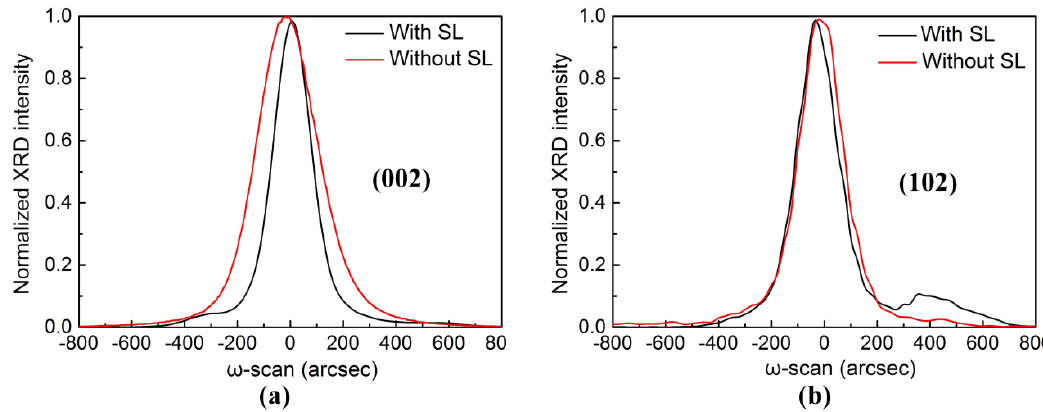
Figure 5. ( a ) Symmetric (002) and ( b ) asymmetric (102) XRD ω -scan rocking curves of green LEDs without and with an InGaN/GaN SL.